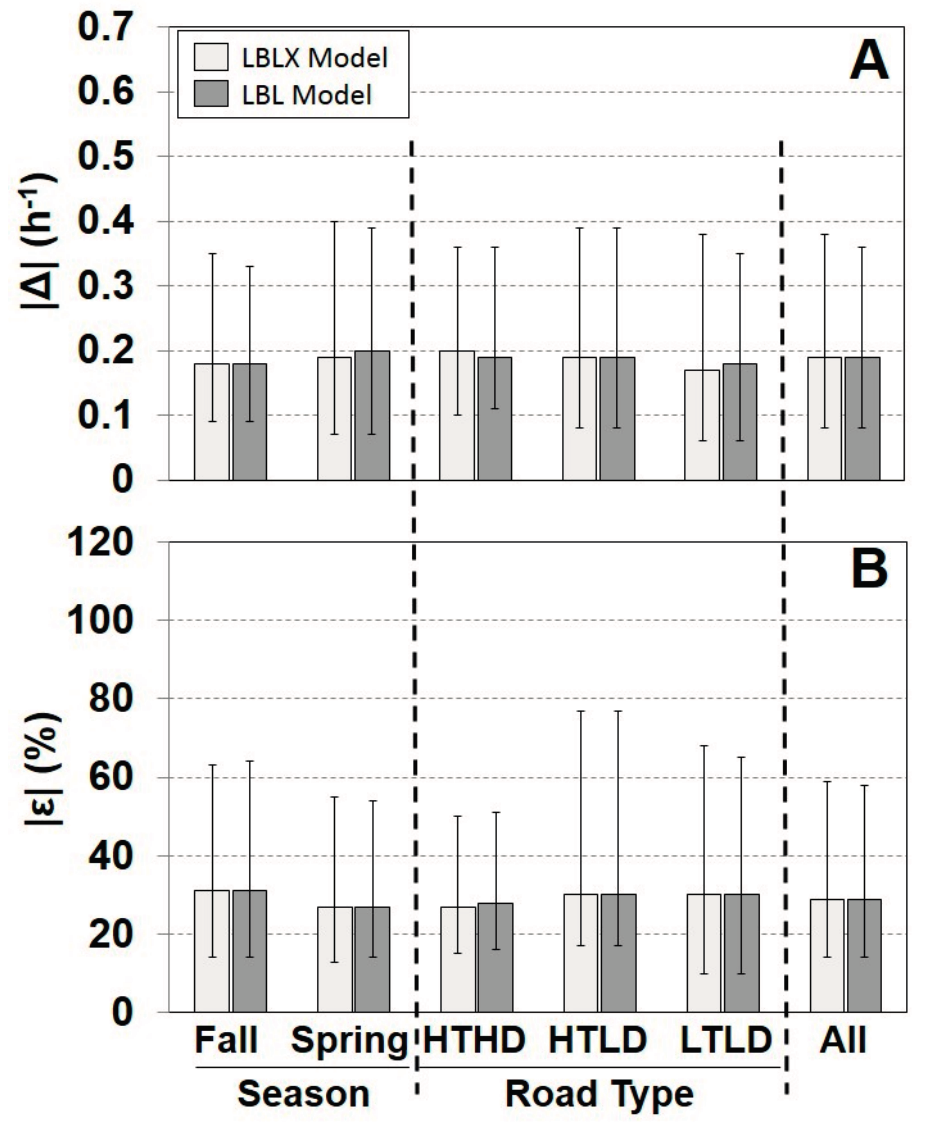
Figure 2. Comparison of absolute differences | Δ | ( A ) and relative differences | ε | ( B ) between individual modeled and measured AER for each model. Results are separated by season, road type, and across all days. Sample sizes are provided in Table 1. Shown are medians with 25th and 75th